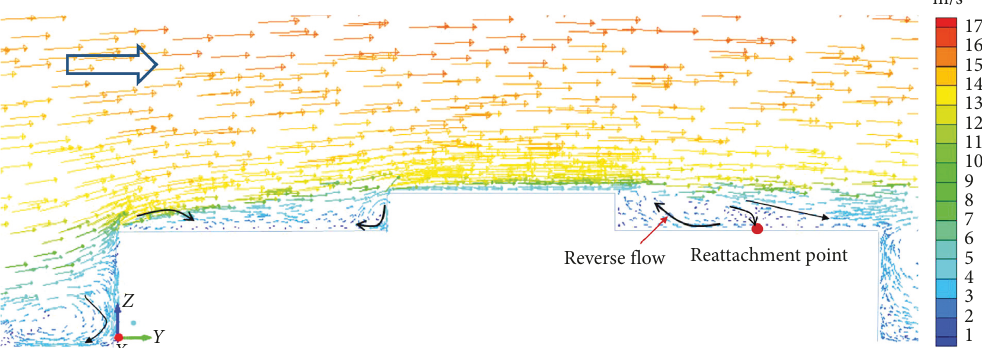
Figure 13: Wind speed vector at midsection when wind direction � 0 ° .